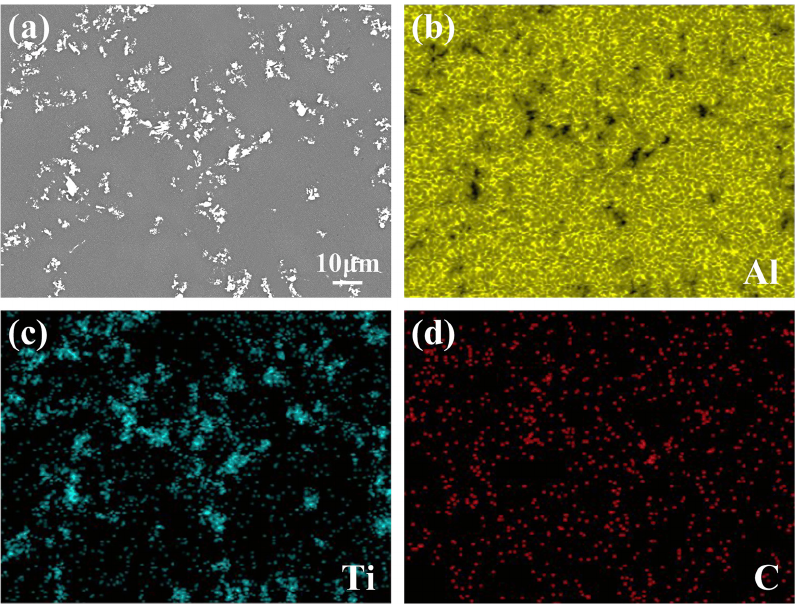
Figure 7. EDS mapping analysis of Al-4Ti-1C composites prepared by 4 μ m graphite: ( a ) microstructure and ( b – d ) mapping micrographs for Al, Ti, and C elements.